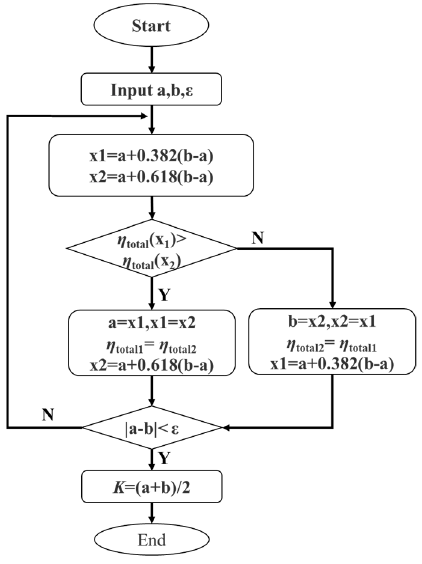
Figure 3. Golden section search algorithm.